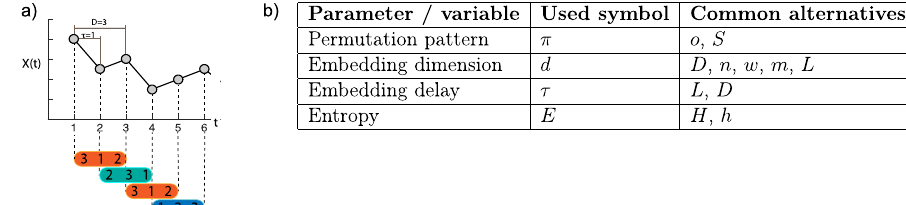
Fig. 1 Mapping time series to ordinal patterns. a Example to illustrate the methodology of mapping a time series into a set of overlapped ordinal patterns, for an embedding dimension d = 3 and an embedding delay τ = 1. Each pattern is obtained by substituting the original values by the respective ranking. For instance, the second value if the smallest of the fi rst three and is thus mapped to number 1 in the fi rst pattern. Note that different symbols have been used to denote the main parameters used in permutation patterns analysis; b reports the symbols used in this work and common variants in the